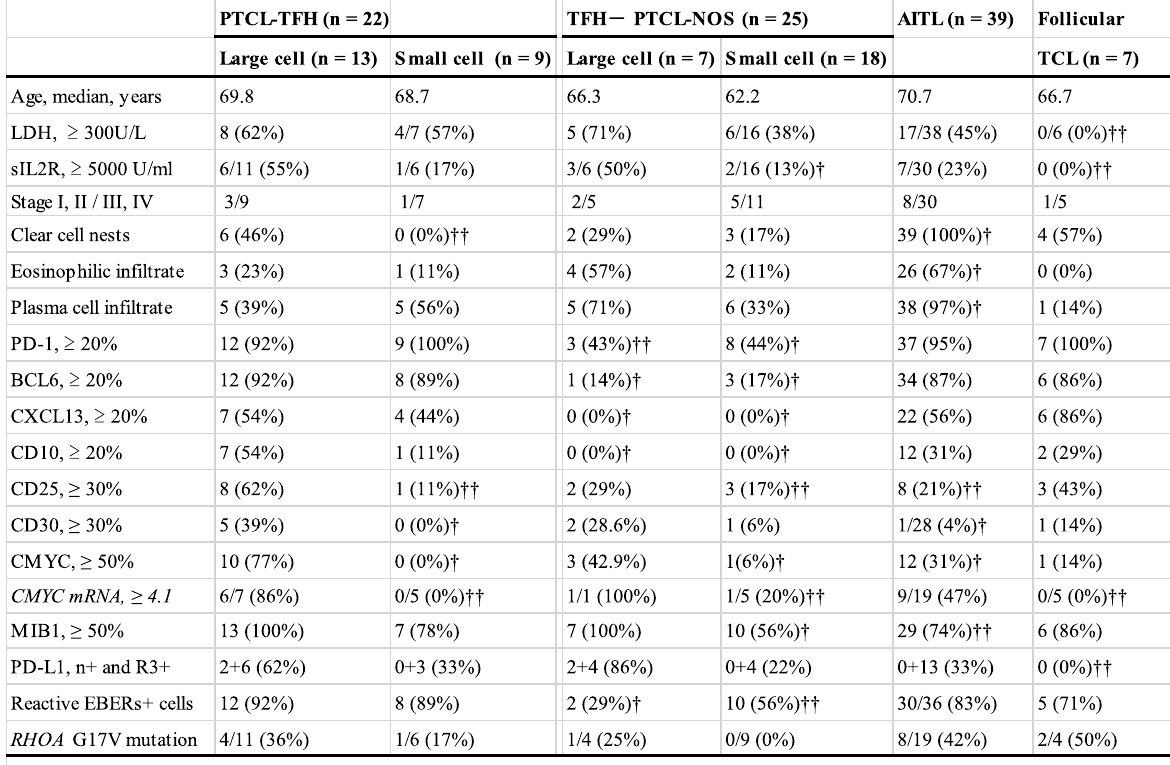
Table 1 Clinical, histological, immunohistological and genetic findings of 93 patients with nodal peripheral T-cell lymphoma, angioimmunoblastic T-cell lymphoma and follicular T-cell